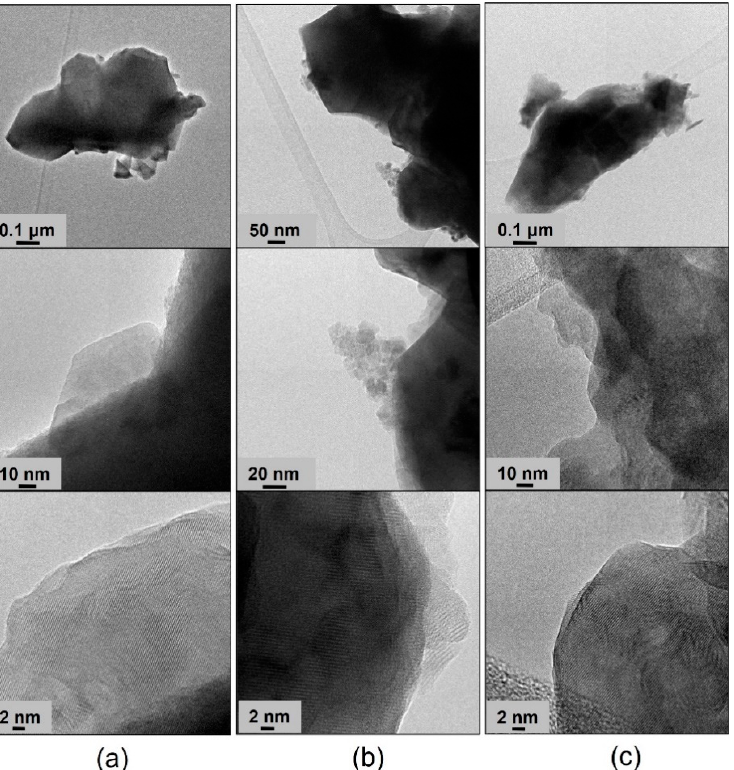
Figure 3. Low-(up), medium-(middle) and high-(down) resolution TEM images of LBSCF ( a ), Figure 3. Low- (up), medium- (middle) and high-(down) resolution TEM images of LBSCF ( a ), LSCF1000 ( b ) and BSCF1000 ( c LSCF1000 ( b ) and BSCF1000 ( c ).